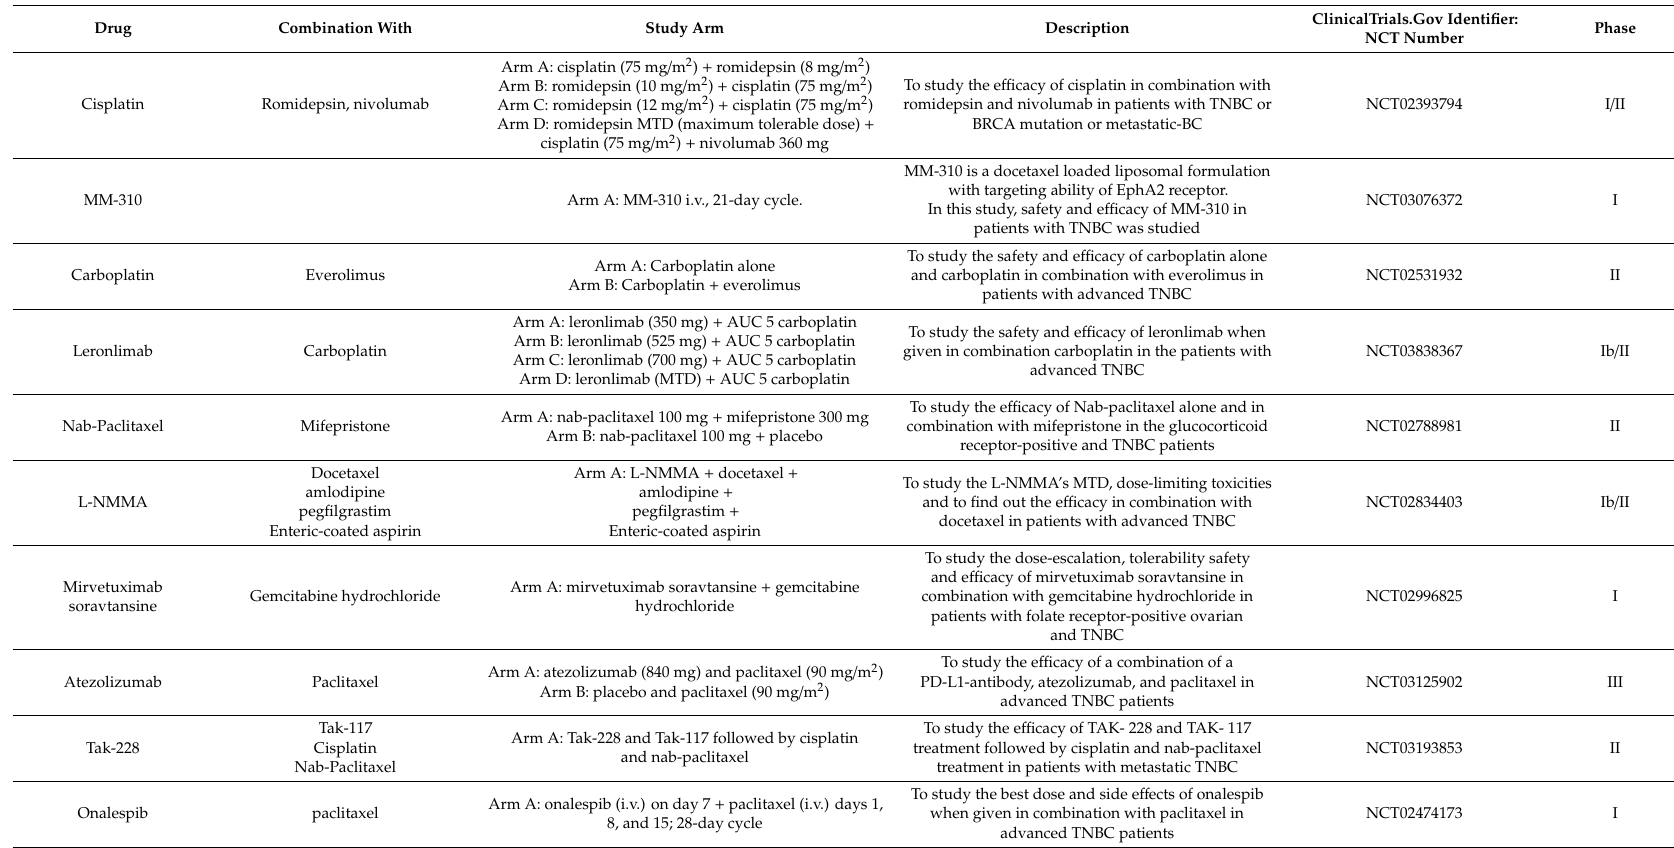
Table 5. List of drugs under clinical trials for the treatment of